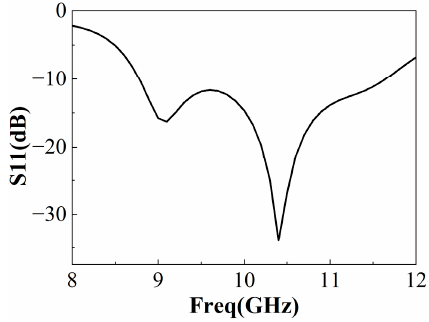
Figure 3. Reflection coefficient of feed antenna.